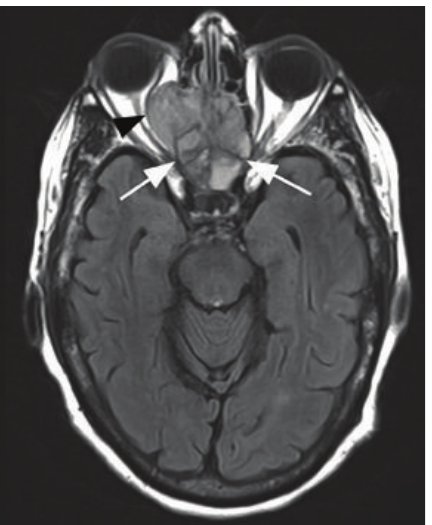
Figure 2: Axial FLAIR T2-weighted brain MRI showing a sinonasal mass involving the ethmoid/sphenoid sinuses (white arrows) with extension into the right orbit (black arrowhead).